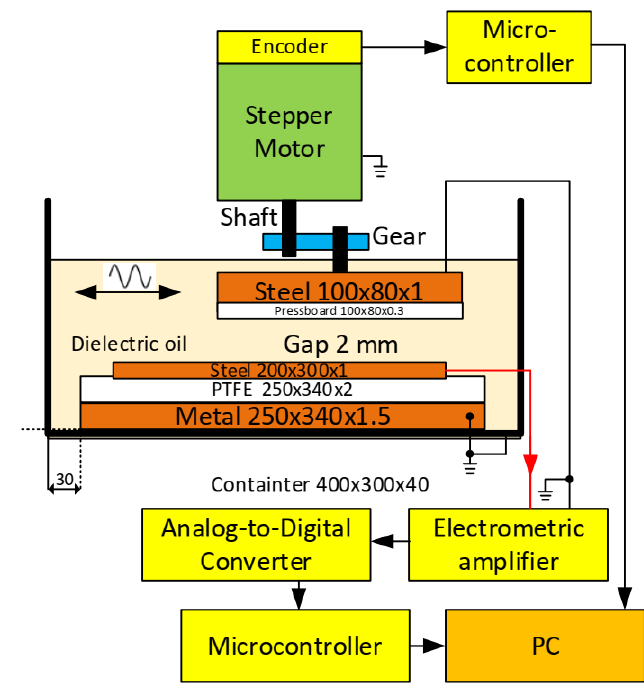
Figure 2. Schematic diagram of the experimental